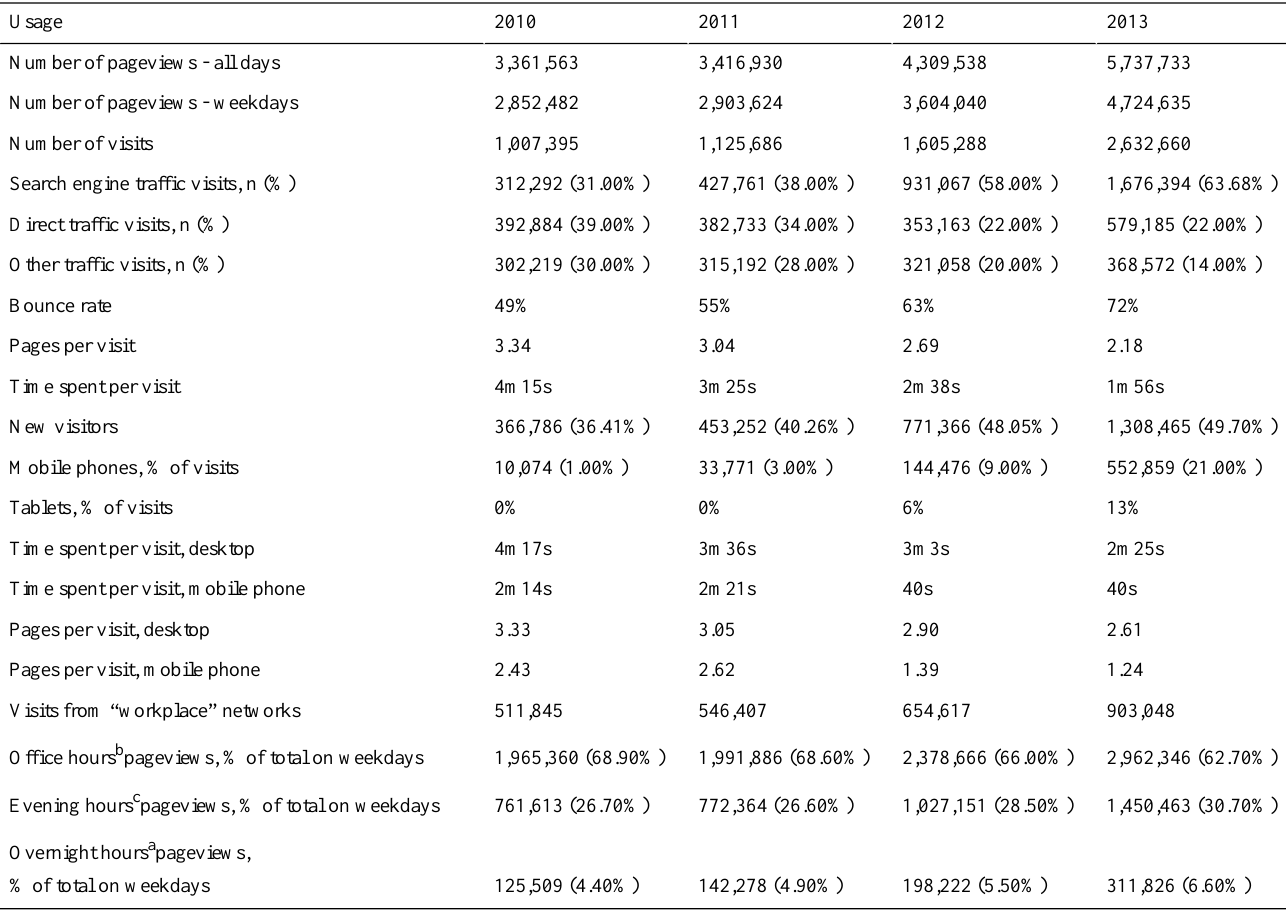
Table 3. Usage statistics for The Library website